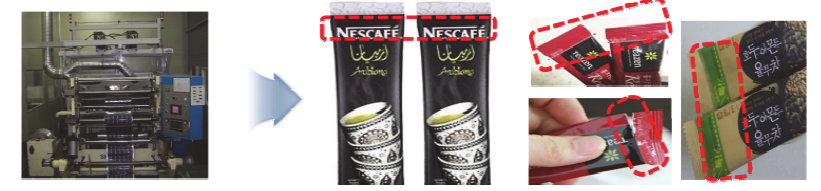
<Figure 8> Food Stick Packaging with Laser Easy-Cut